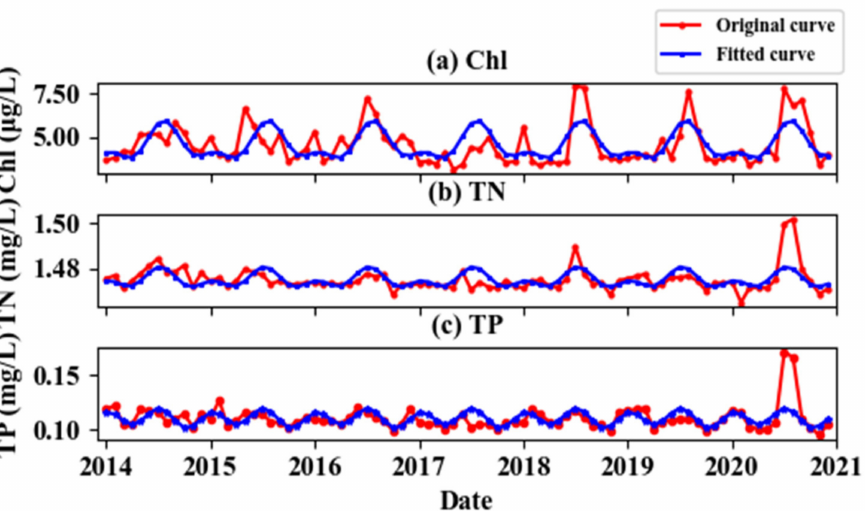
Figure 6. Fitting results of the monthly variations trend of the water quality parameters from 2014 to 2020. ( a – c ) are the monthly variations of Chl-a, TN, and TP concentration,